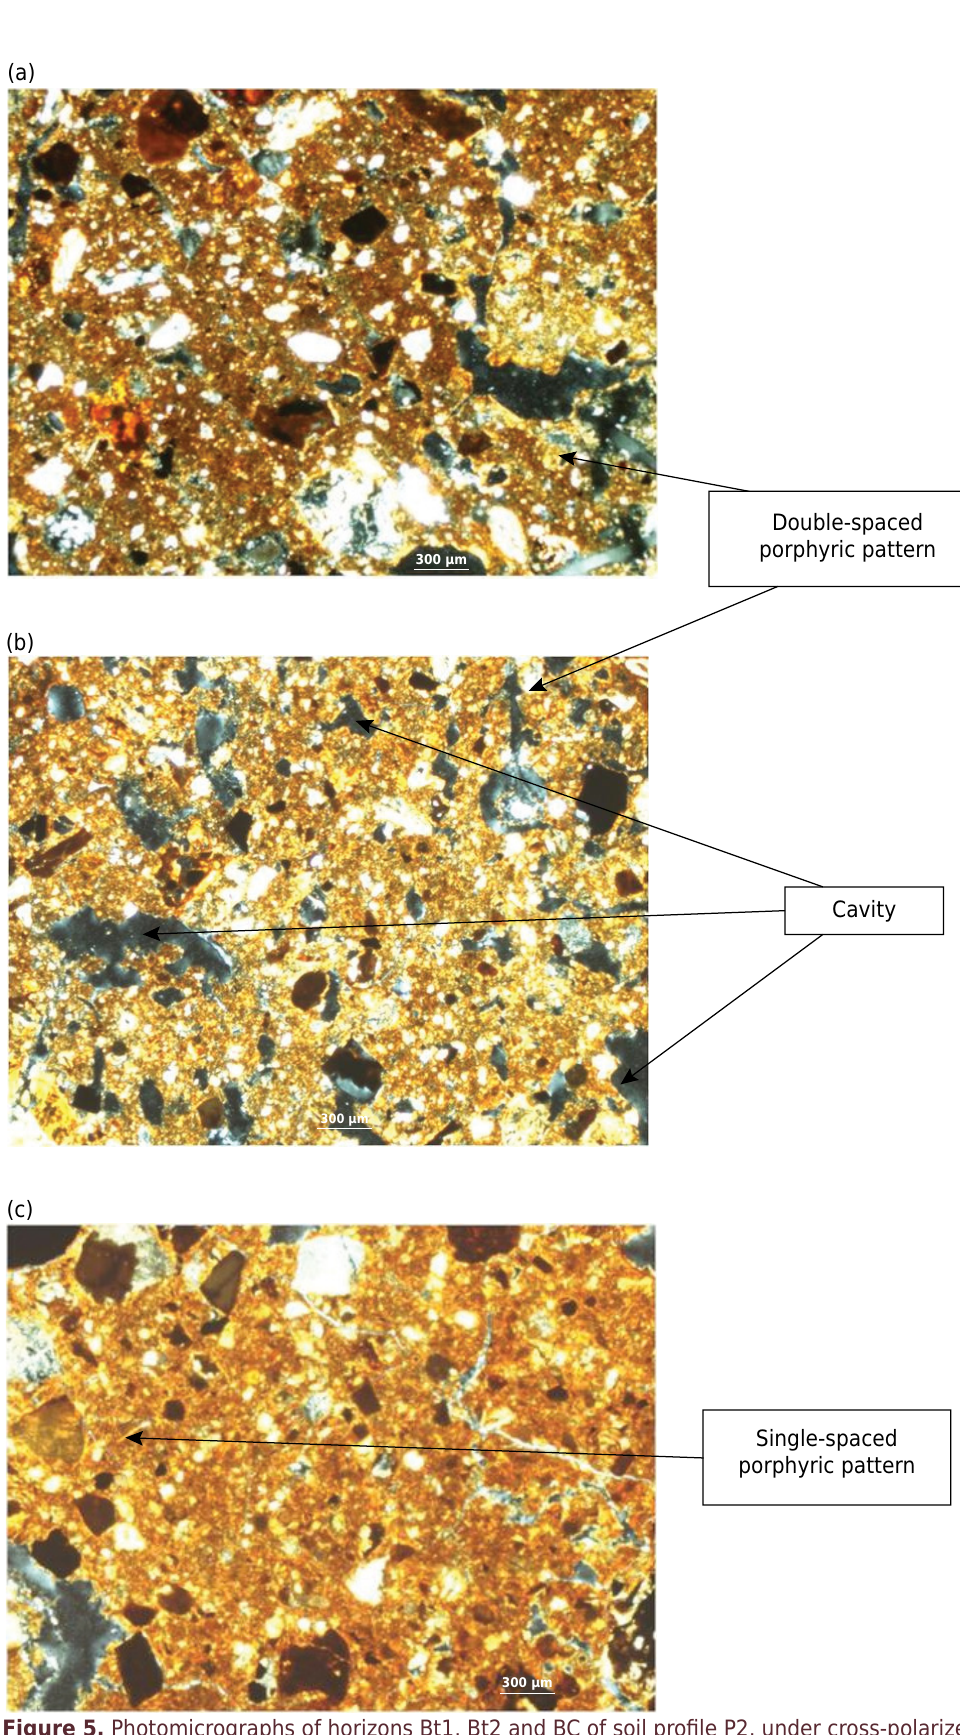
Figure 5. Photomicrographs of horizons Bt1, Bt2 and BC of soil profile P2, under cross-polarized light (XPL); (a) groundmass of horizon Bt1 with double-spaced porphyric fabric; (b) groundmass of horizon Bt2 with double-spaced porphyric fabric; (c) groundmass of horizon BC with single-spaced porphyric